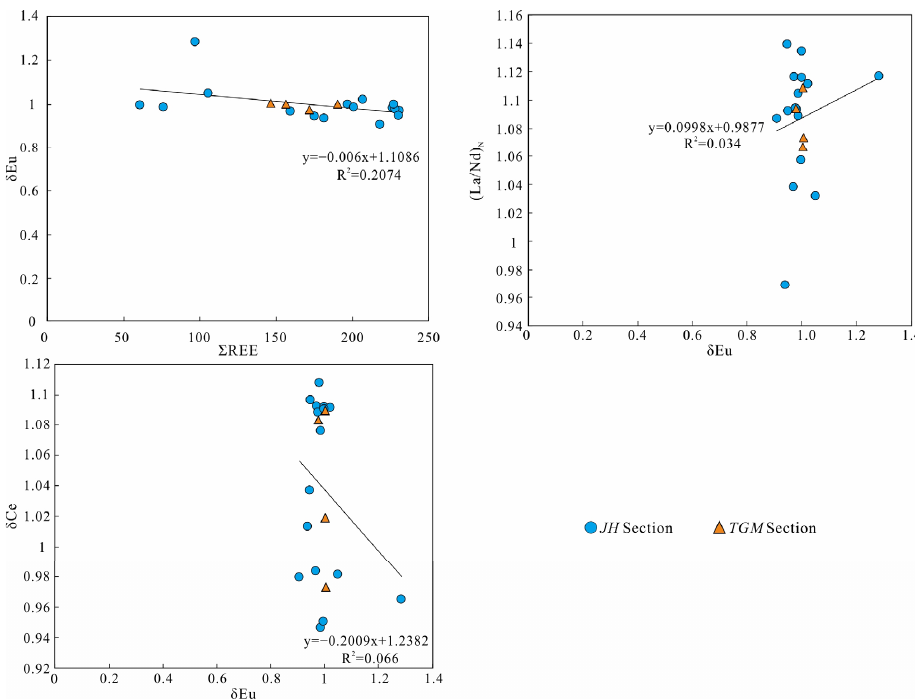
Figure 7. Data validity discrimination diagram of the JH and TGM sections.